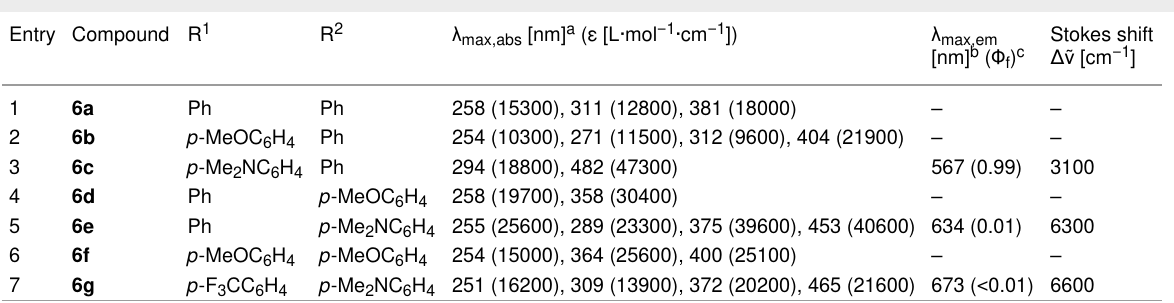
Table 8: Photophysical properties of α -pyrones 6 .